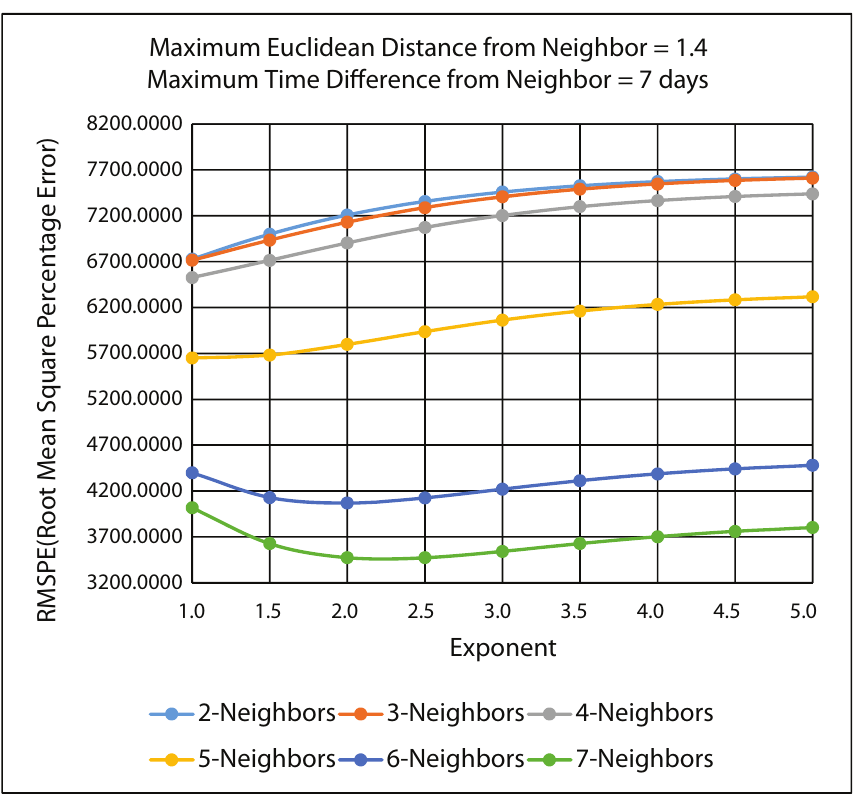
Figure 21. RMSPE 10-fold cross-validation results for the various 45 IDW methods using the improved IDW interpolation.